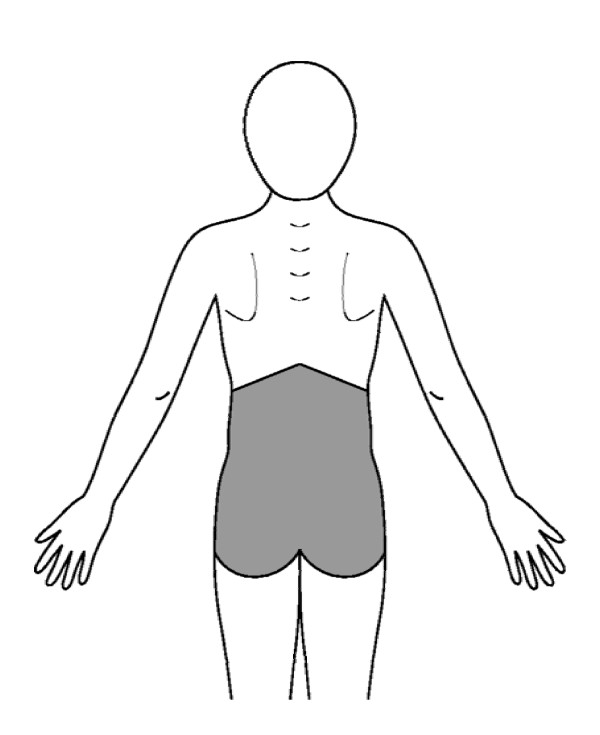
Spatial location of low back pain [13].